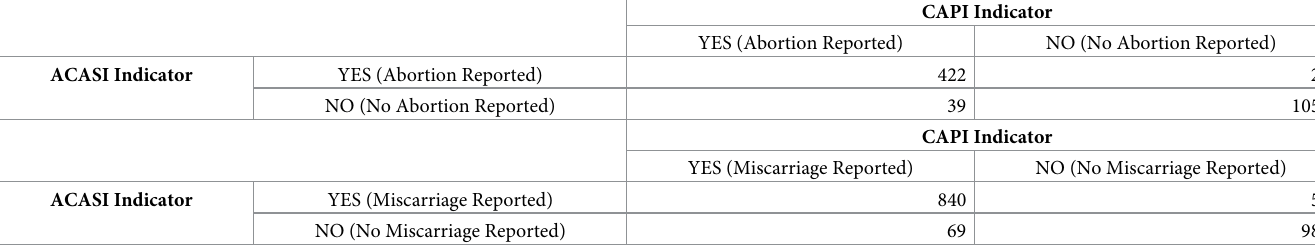
Table 1. Unweighted cross-tabulation of the ACASI and CAPI indicators of abortion and